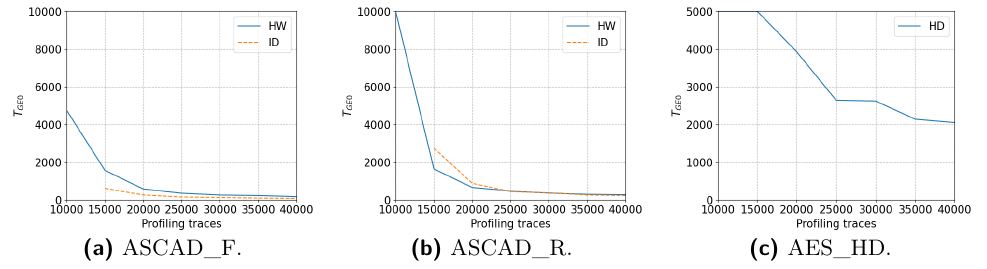
Figure 11: The effect of training set